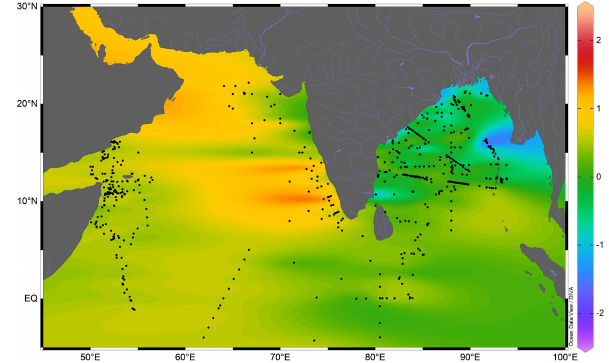
Figure 8. The surface seawater oxygen isotopic ratio (‰) in the northern Indian Ocean. The black-filled circles are the seawater sample locations compiled from previous studies. The thin blue lines are the major rivers draining in the northern Indian Ocean. The map was prepared by using Ocean Data View software (Schlitzer,